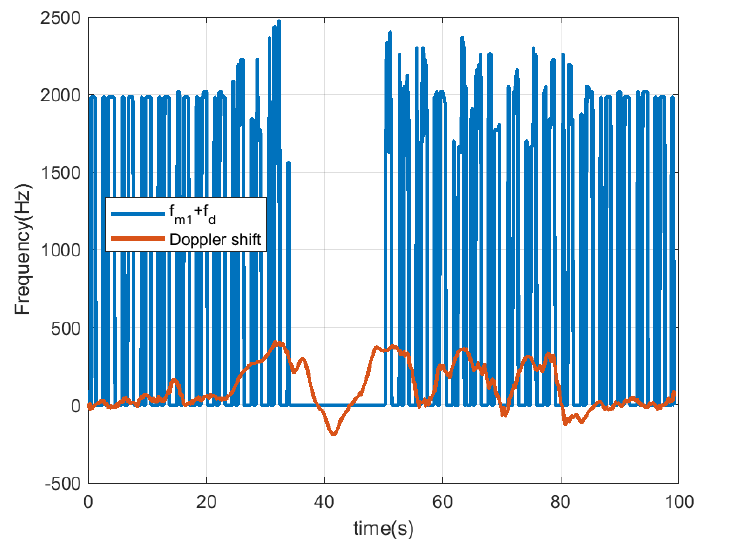
Figure 27. Data measurement using length 7 Barker codes when the scooter is in motion: scooter Doppler frequency estimate and detected frequency for bit 1. In this case, the tag is partially out of